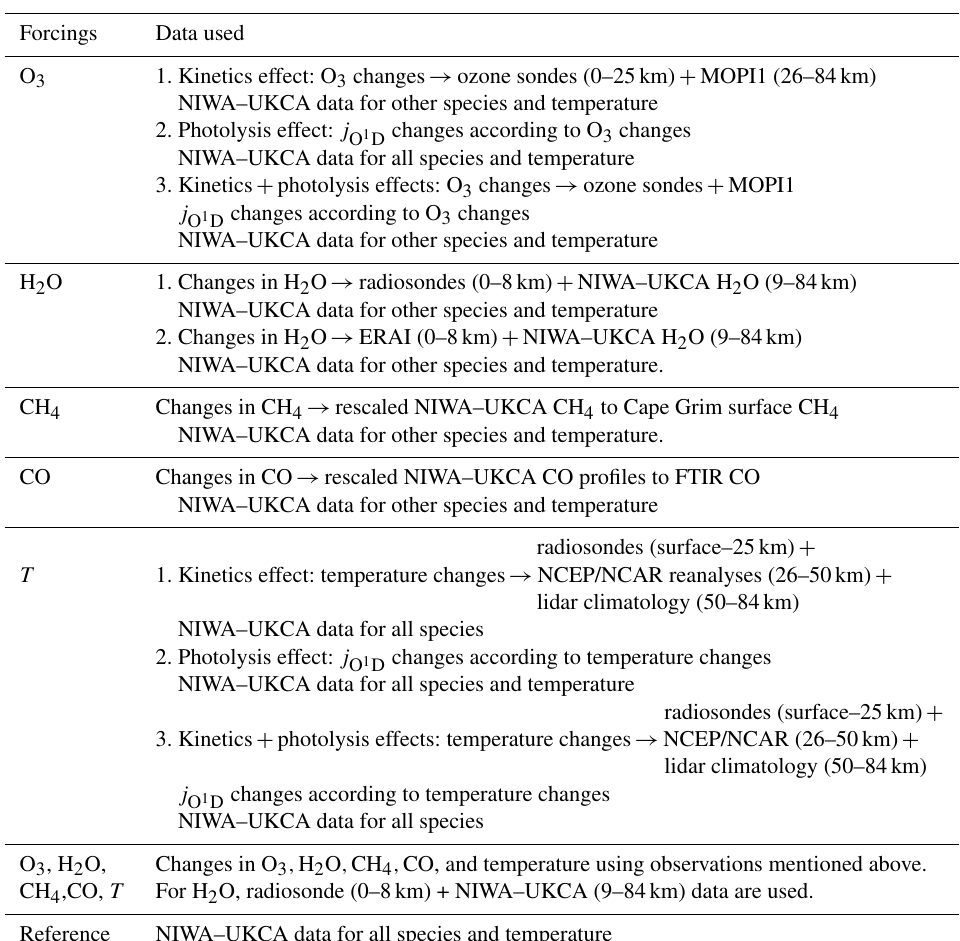
Table 1. Simulations performed with the SCM to assess the contribution of changes in the key forcings to OH chemistry at Lauder under clear-sky conditions. The table includes the type of measurement/dataset used to prescribe the key forcings. The time period of simulation is between 1994 and